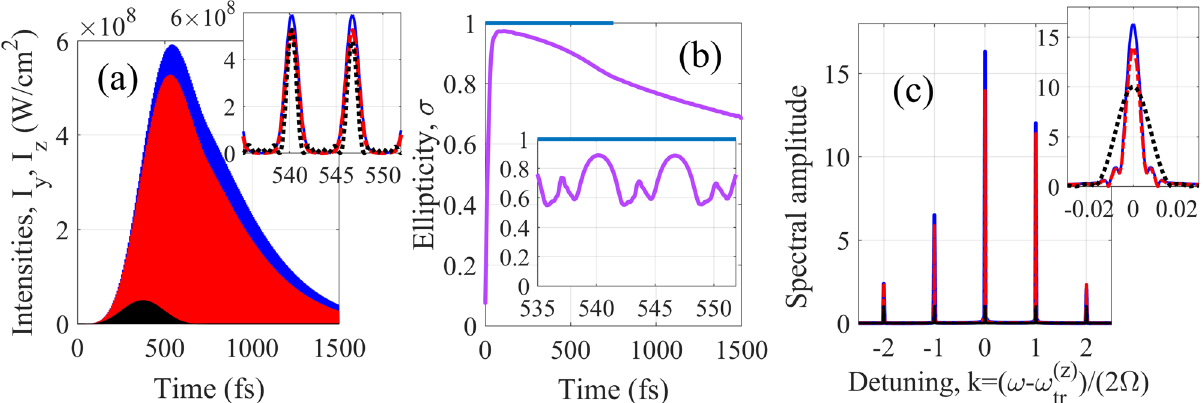
Figure 4. The result of amplification of the HHs resonant to the gain lines marked by red circles in Fig. 3. ( a ) Time dependences of the intensities of the polarization components of the HH field. Black dotted curve and lowest intensity correspond to the incident field. Red dash-dot and blue solid curves are y - and z - components of the amplified field, respectively. In the inset, the intensity of the incident field is multiplied by factor 30 for visibility. ( b ) Ellipticity of the incident, blue line, and amplified, lavender curve, HH field at the maxima of individual pulses. Inset shows the ellipticity time dependence within the IR-field cycle. ( c ) Fourier transform of the polarization components of the incident field (black dotted curve) and amplified field (red dash-dot and blue solid curves showing y -and z -polarization components, respectively). Inset shows the shape of individual harmonic line (in the inset, the spectrum of the incident field is multiplied by factor 10 for